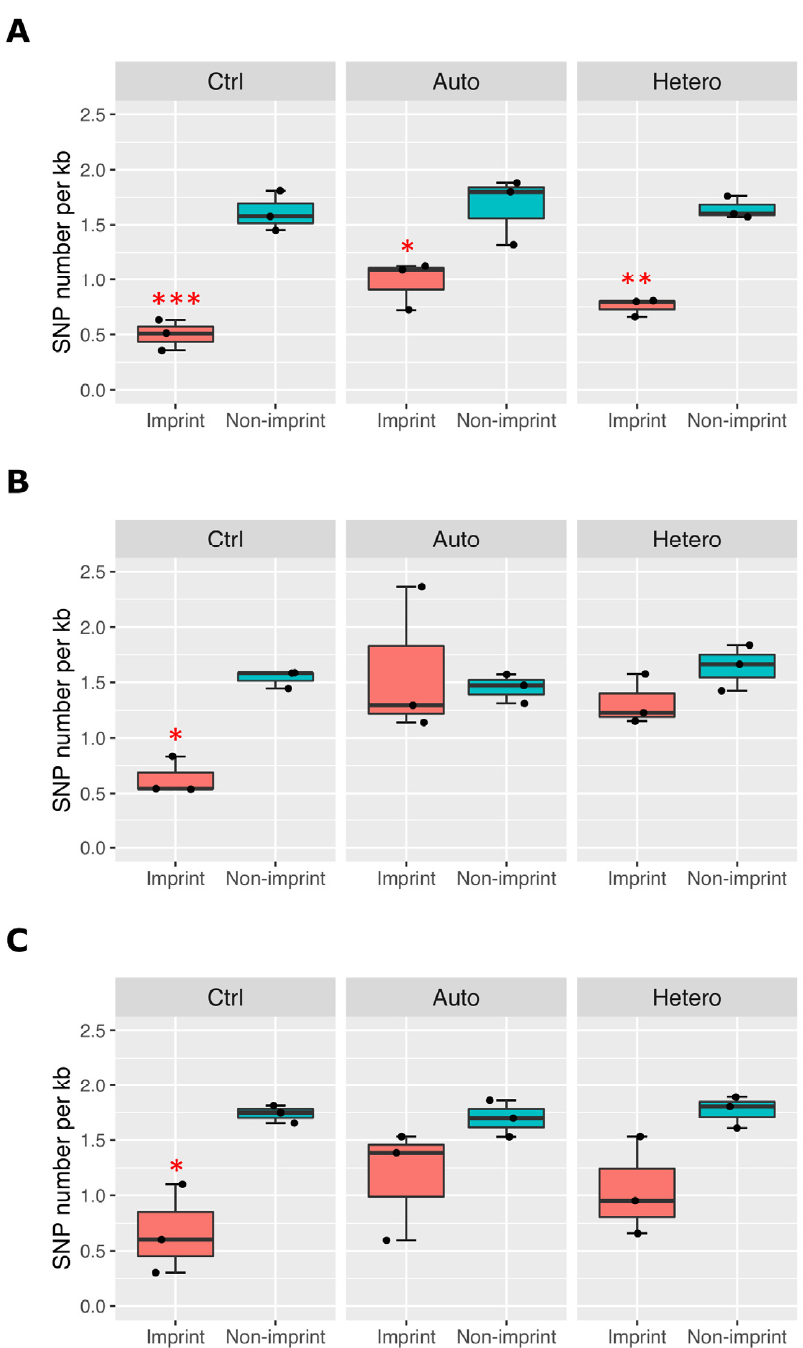
Figure 5. Biallelic expression of genes on imprinted loci in the tissues from control pigs (Ctrl) or pigs derived from autologous (Auto) and heterologous (Hetero) mtDNA supplementation. SNP frequency normalised by size of transcript (per kb) was measured as an indicator of biallelic expression for imprinted and non-imprinted genes from ( A ) brain, ( B ) heart and ( C ) liver RNAseq data. Significant differences identified by ANOVA and Tukey test are indicated by asterisks (*, p < 0.05; ** p < 0.01; ***, p < 0.001).